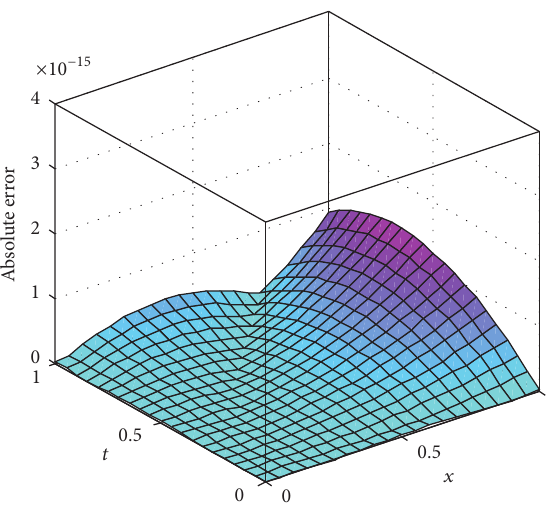
Figure 8: The absolute error for Example 3 with 𝑚 = 6 .